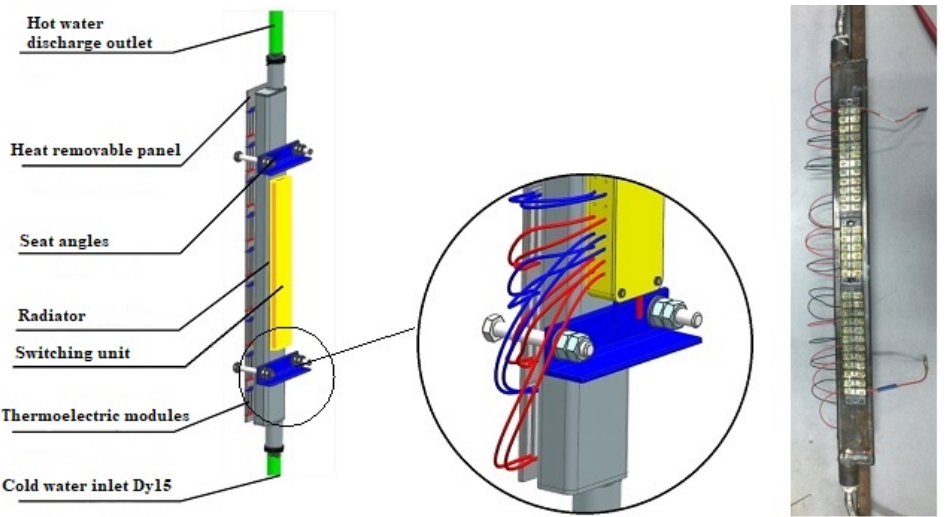
Figure 5. General view and commutation of the thermoelectric modules.